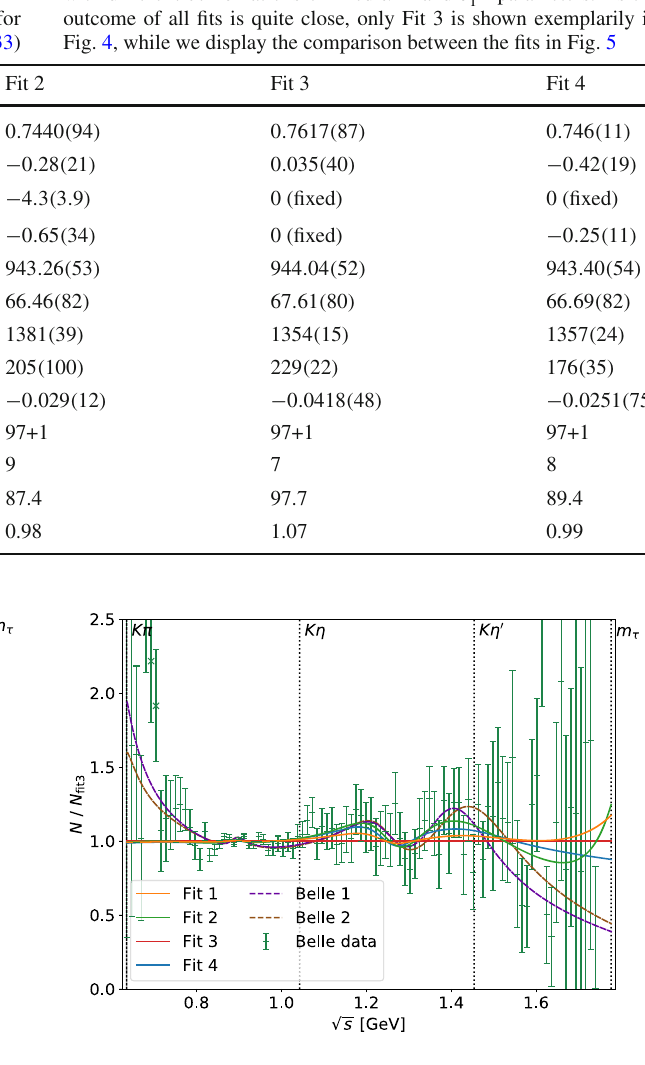
( 1 ) parameters. As the 1